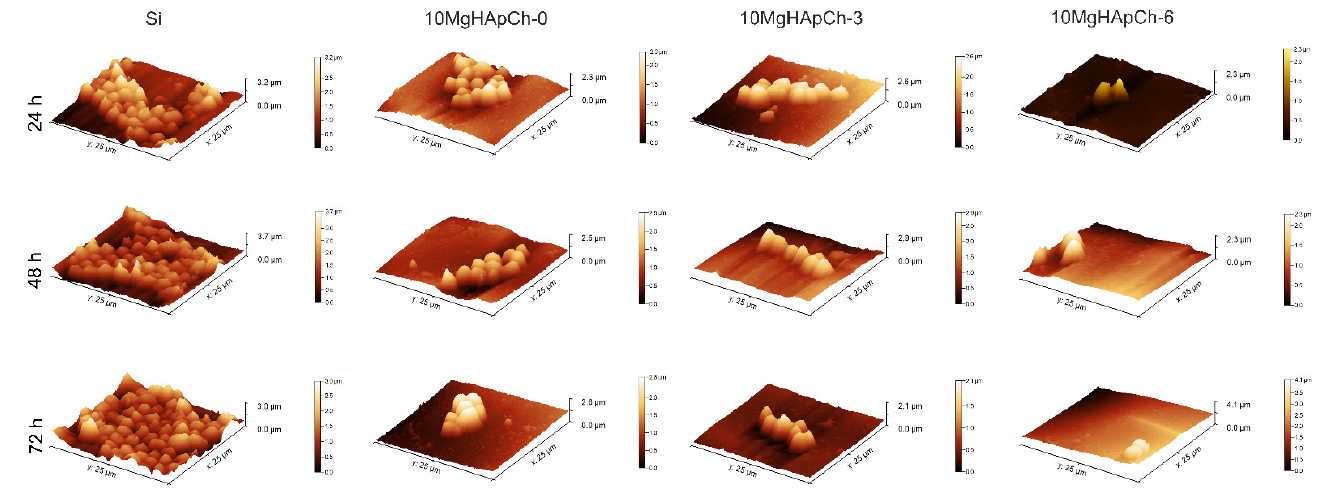
Figure 15. 3D representation of AFM surface topography of Candida albicans ATCC 10231 cell devel- opment on Si discs, 10 MgHApCh-0, 10 MgHAp-Ch-3, and 10 MgHAp-Ch-6 composite layers after 24 h, 48 h, and 72 h of incubation collected on an area of 25 × 25 µm 2 .